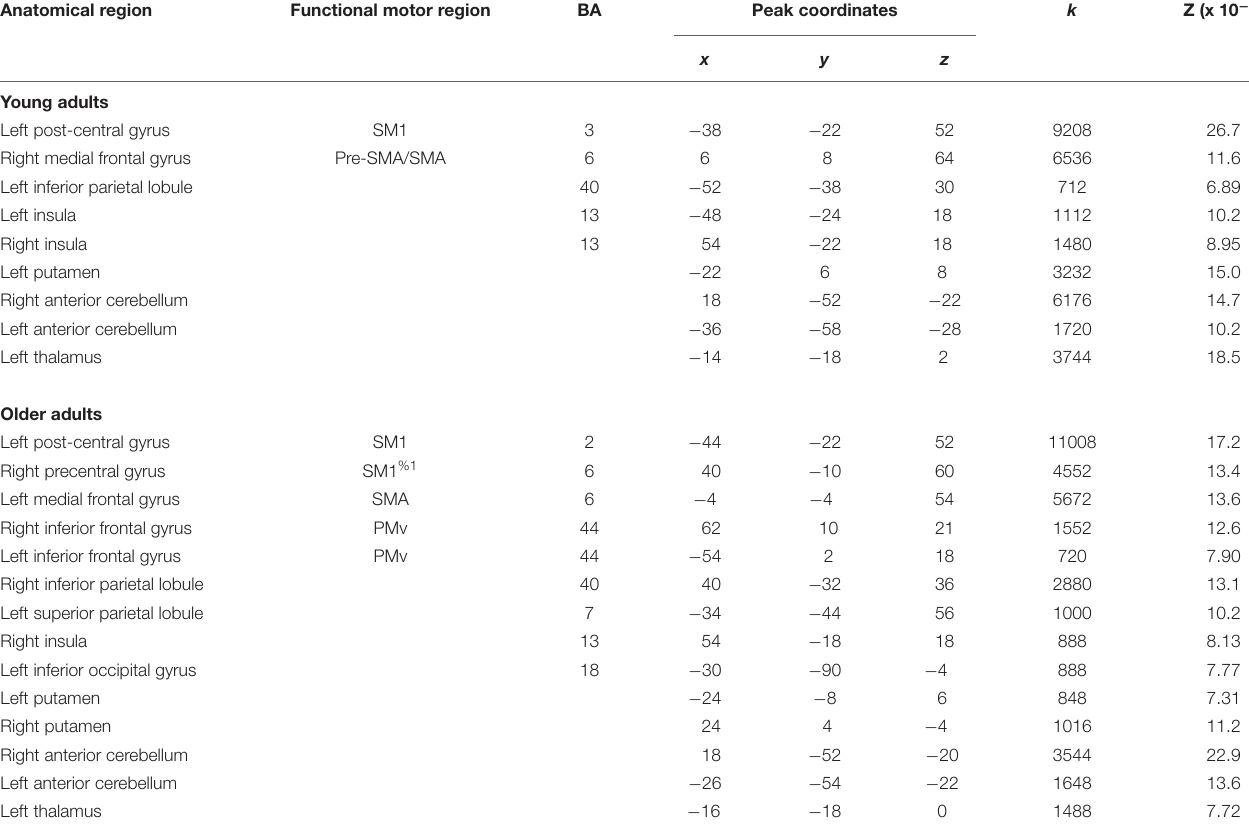
TABLE 3 | Activation likelihood estimation (ALE) peaks for within-group contrasts for right hand movements. Anatomical